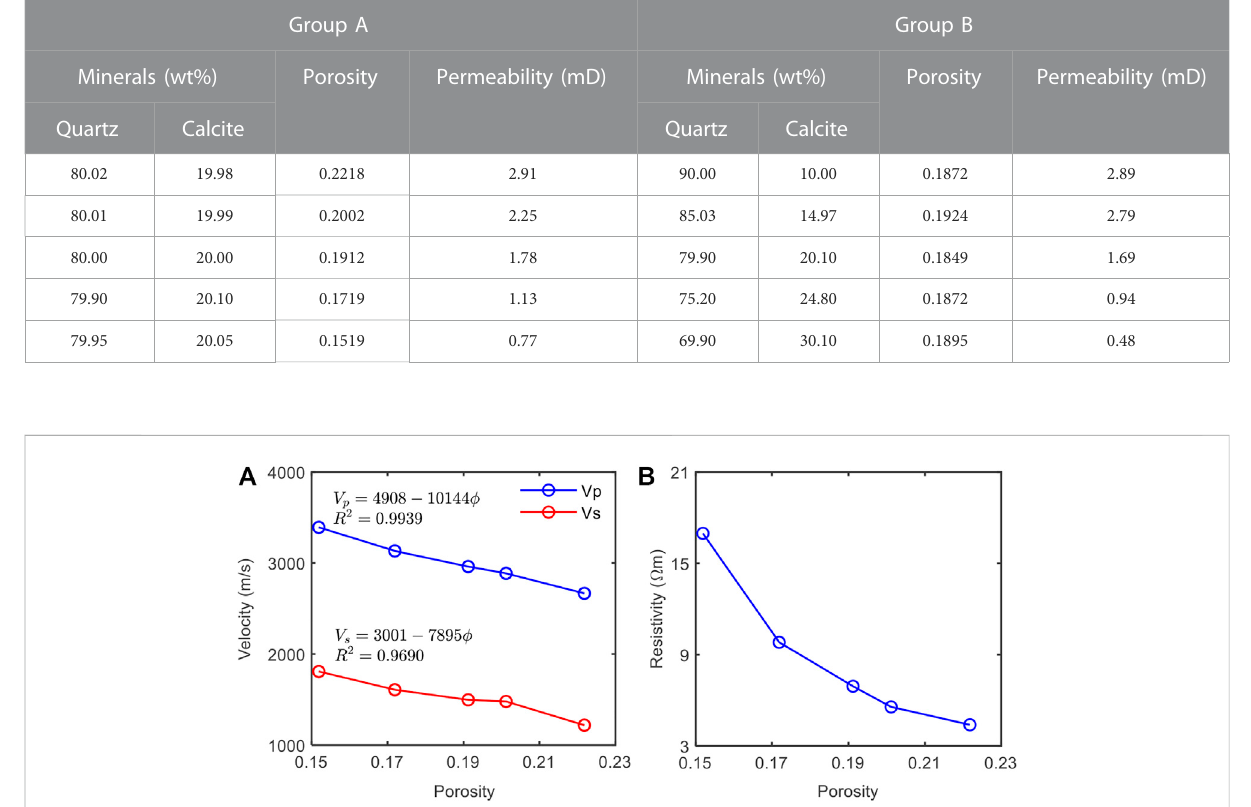
TABLE 1 Mineral composition, porosity and permeability of the arti fi cial sandstones.